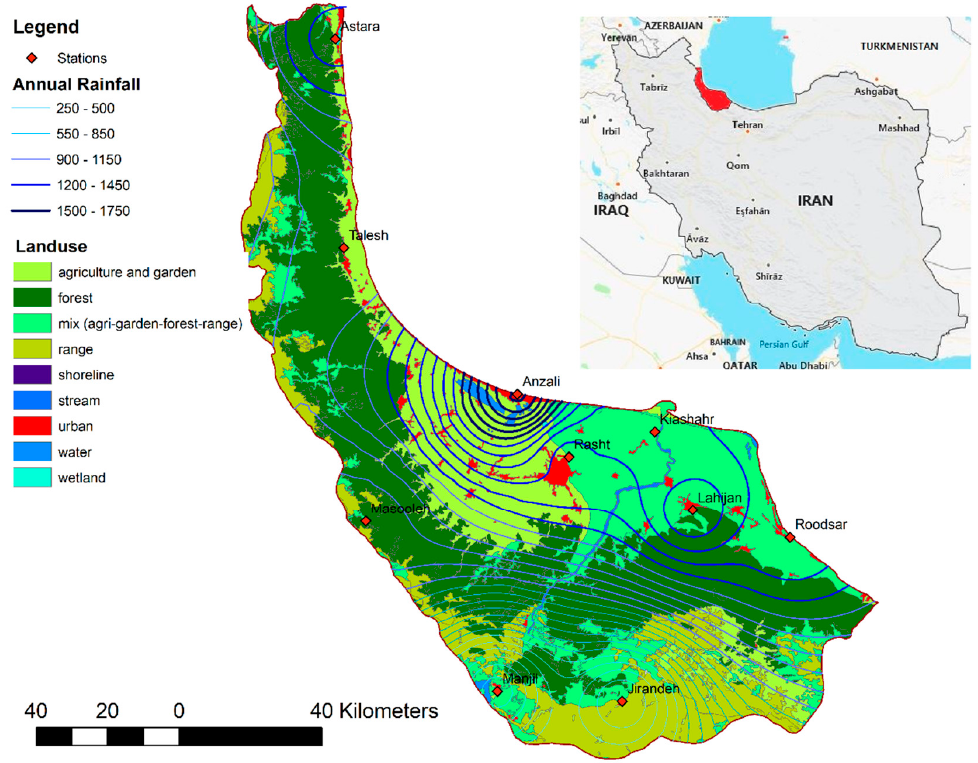
Figure 2. Rainfall stations and cities in the study area.